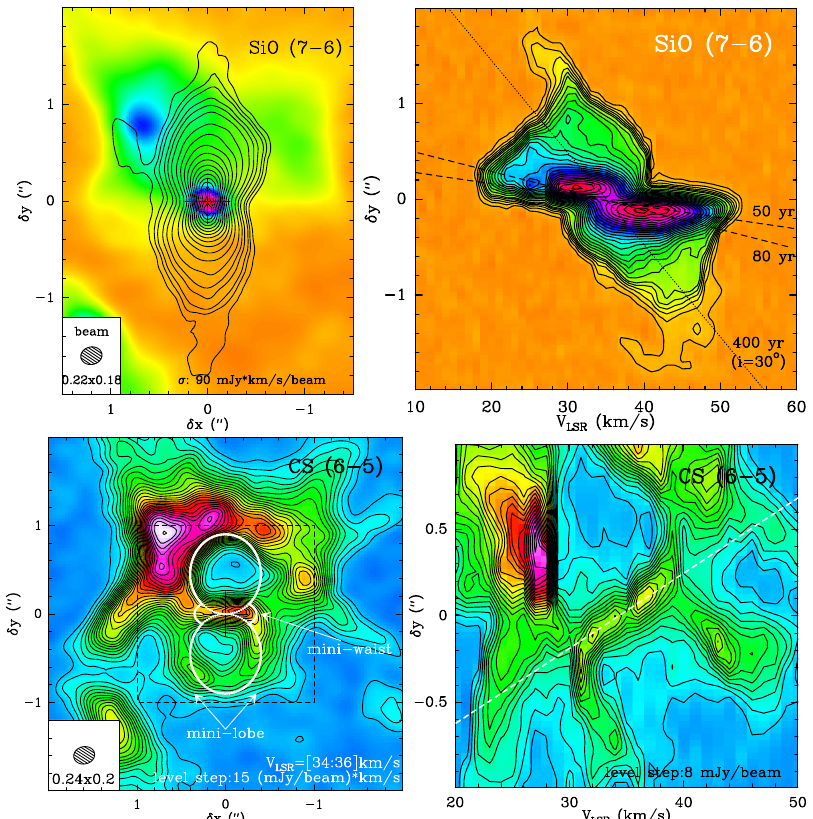
Figure 3. SiO(7 − 6) and CS(6 − 5) emission in OH231.8 + 4.2. ( Left ) Zero-order moment maps (integrated over V LSR = [18:53] and [34:36] kms − 1 , for SiO and CS, respectively). The mini-hourglass centred at clump S is schematically depicted in the bottom-left panel. ( Right ) Position-velocity (PV) diagrams along PA = 21 ◦ . The lines represent different velocity gradients implying different kinematic ages at various regions of the SiO-outflow (top) and along the mini-waist (bottom). The ∼ 8 (cid:48)(cid:48) × 4 (cid:48)(cid:48) -sized hourglass nebula traced by the dust thermal continuum emission maps is